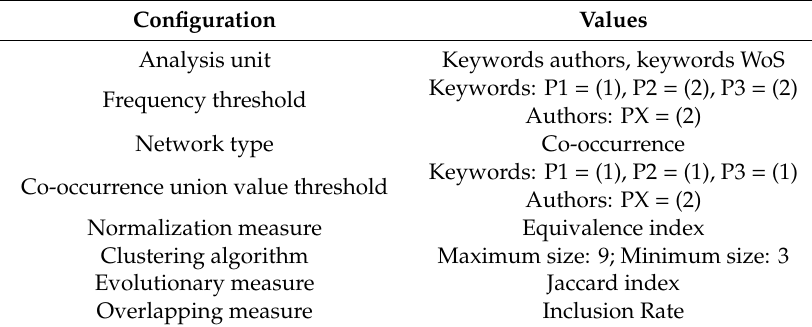
Table 1. Production indicators and inclusion criteria